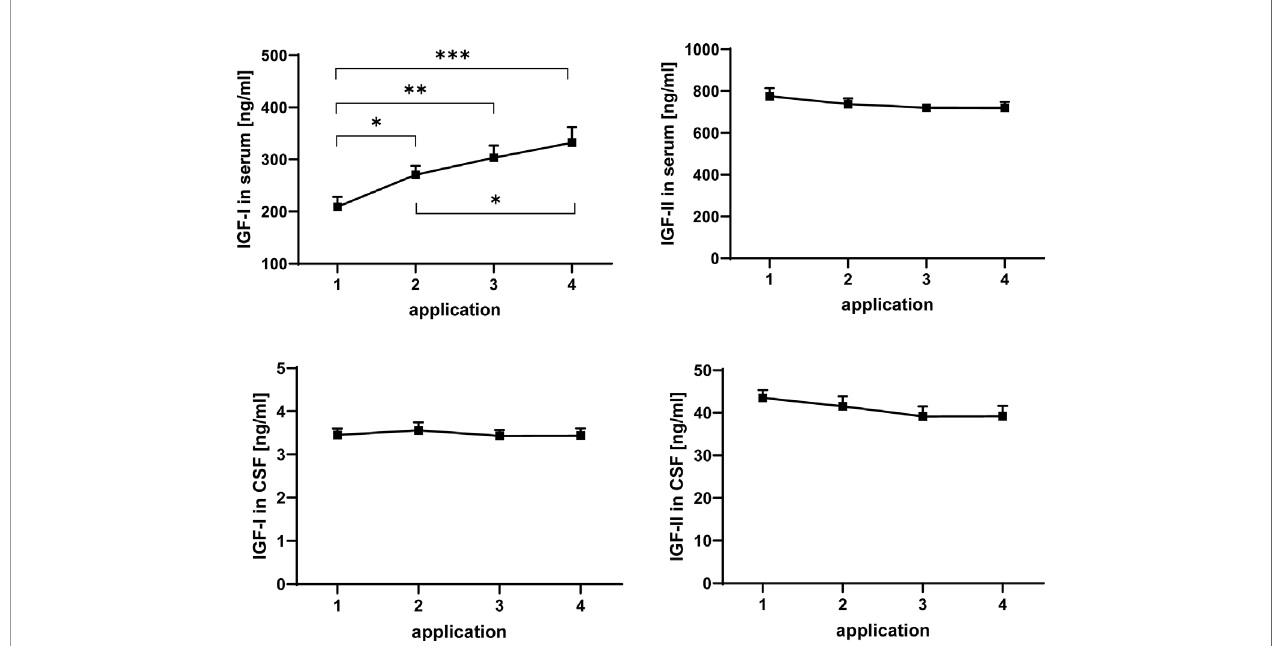
FIGURE 2 | Concentrations of IGF-I (left panels) and IGF-II (right panels) in serum (upper panels) and CSF (lower panels) in MS patients at consecutive time points of intrathecal TCA injection. The data are based on sample series from 20 treatment cycles (14 cycles in four males and 6 cycles in two females) and are given as means ± SEM (signi fi cant differences are indicated; *p < 0.05; **p < 0.01; ***p < 0.001).